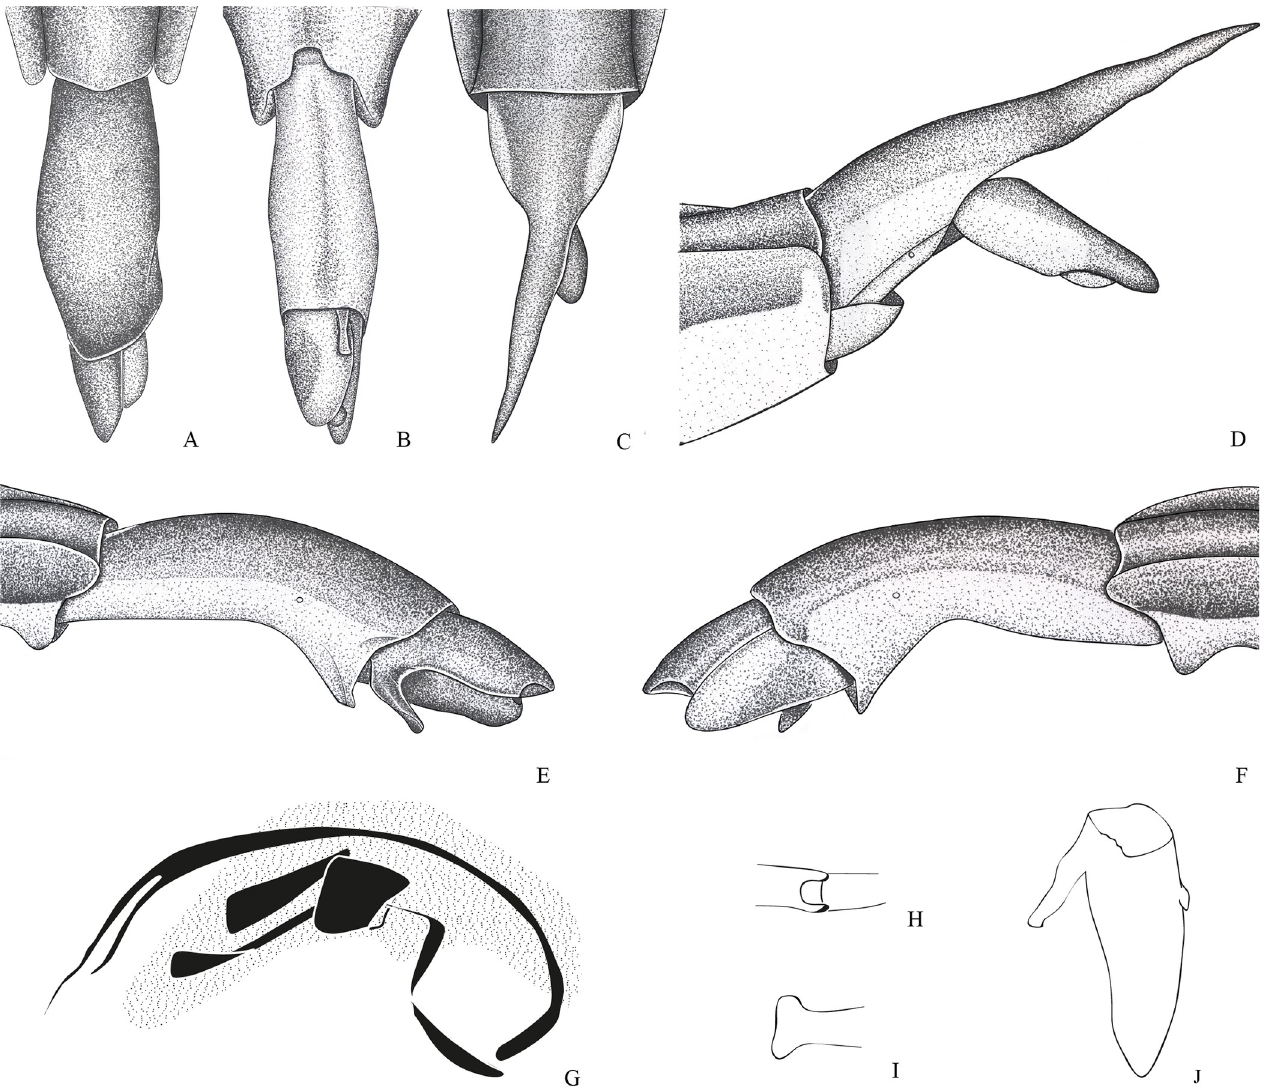
Fig 8. Potamobates osborni . (A) Male, terminalia, dorsal view; (B) male, terminalia, ventral view; (C) female, terminalia, dorsal view; (D) female, terminalia, left lateral view; (E) male, terminalia, left lateral view; (F) male, terminalia, right lateral vire; (G) phallus, lateral view (H) junction between dorsal and ventral sclerite; (I) base of ventral sclerite; (J) proctiger, dorsal view.